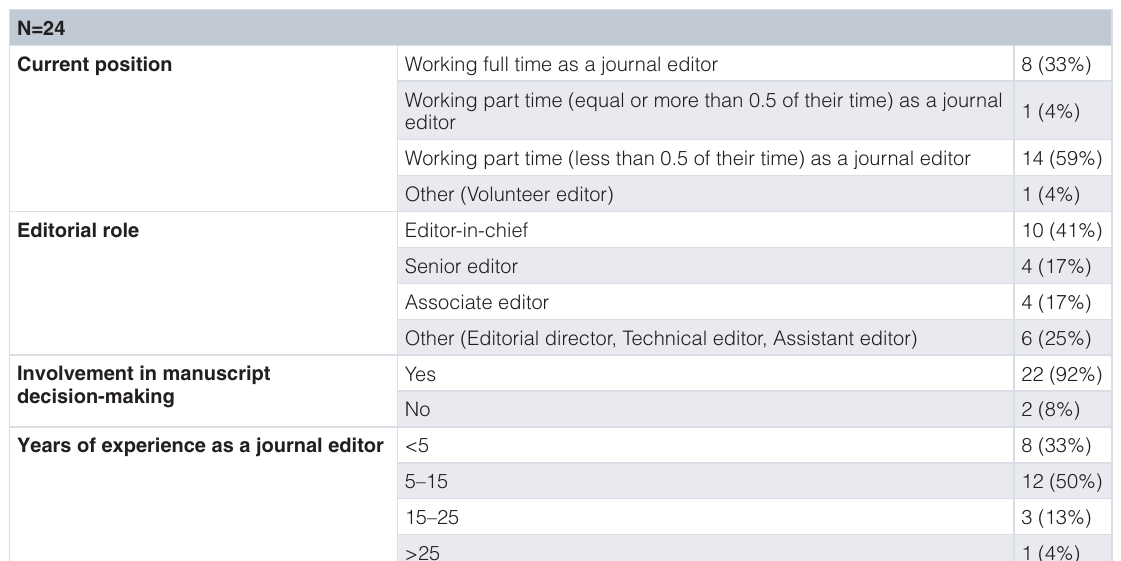
Table 2. Demographic characteristics of the 24